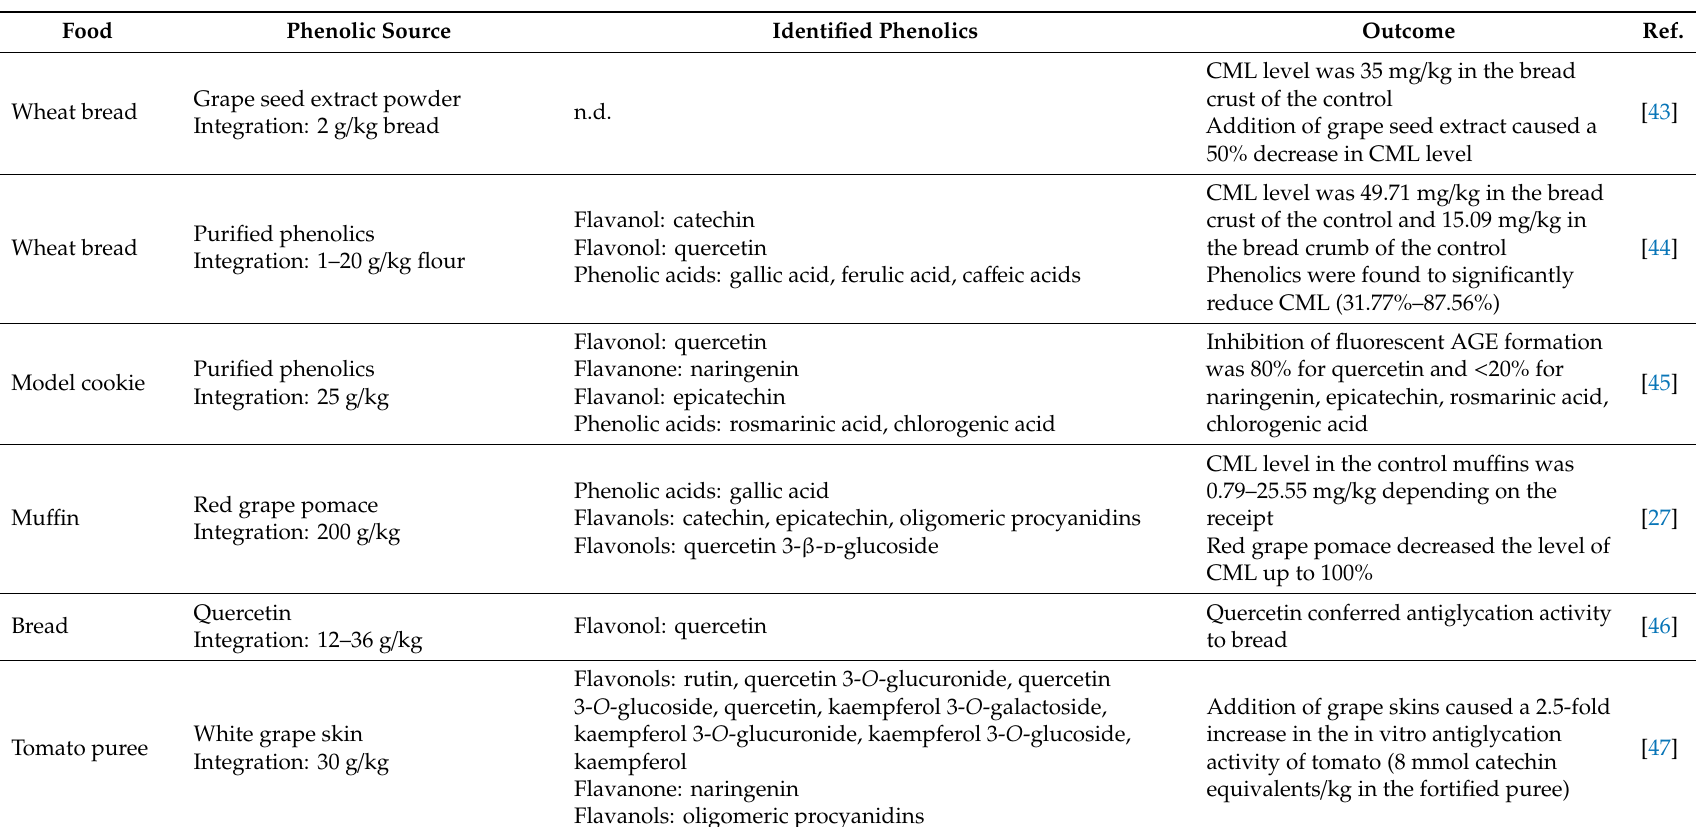
Table 2. Use of grape pomace-derived phenolics to inhibit AGE formation in foods or to increase the potential antiglycation activity of foods.